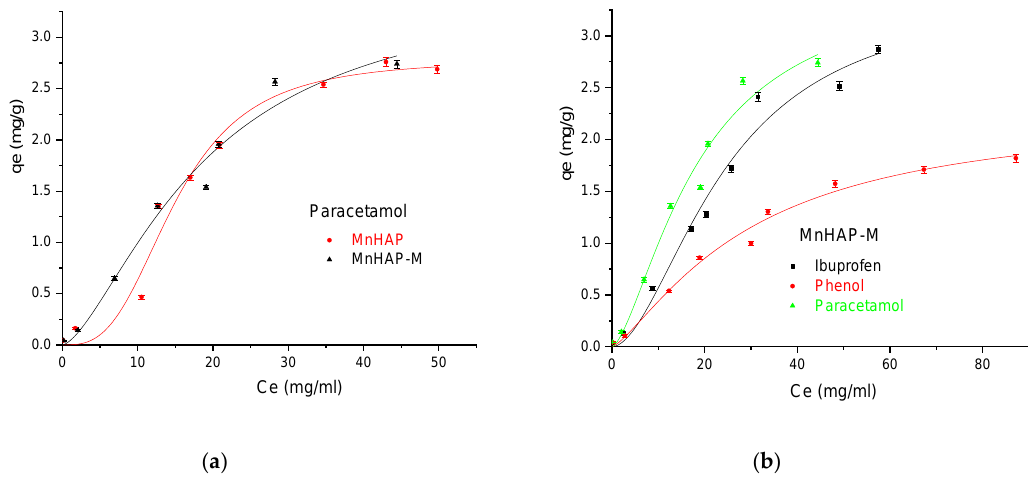
Figure 9. ( a ) Influence of the adsorbent type in the adsorption process using paracetamol as pollutant; ( b ) Influence of the pollutant type in the adsorption process using the MnHAP-M composite material. Table 3. Parameters obtained from the Langmuir, Freundlich, Sips, and Temkin models. Pollutant Phenol Adsorbent